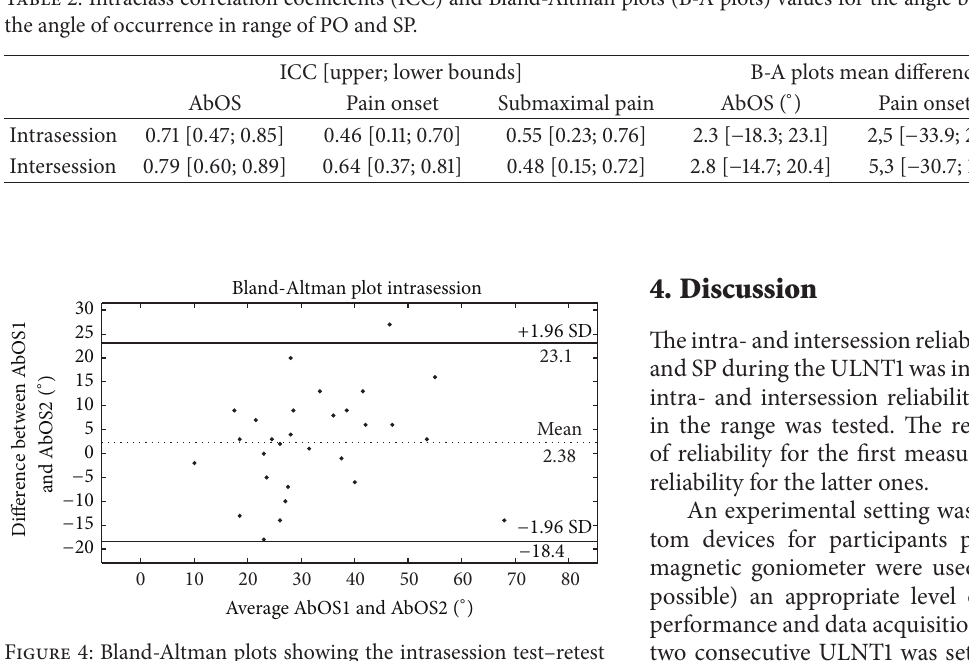
calculated in the B-A plots was − 0.4 ∘ and the 95% limits of agreement were − 2.0 ∘ and 1.1 ∘ . The mean difference VAS 1 − VAS 3 was − 0.1 ∘ and the 95% limits of agreement were − 2.0 ∘ and 1.7 ∘